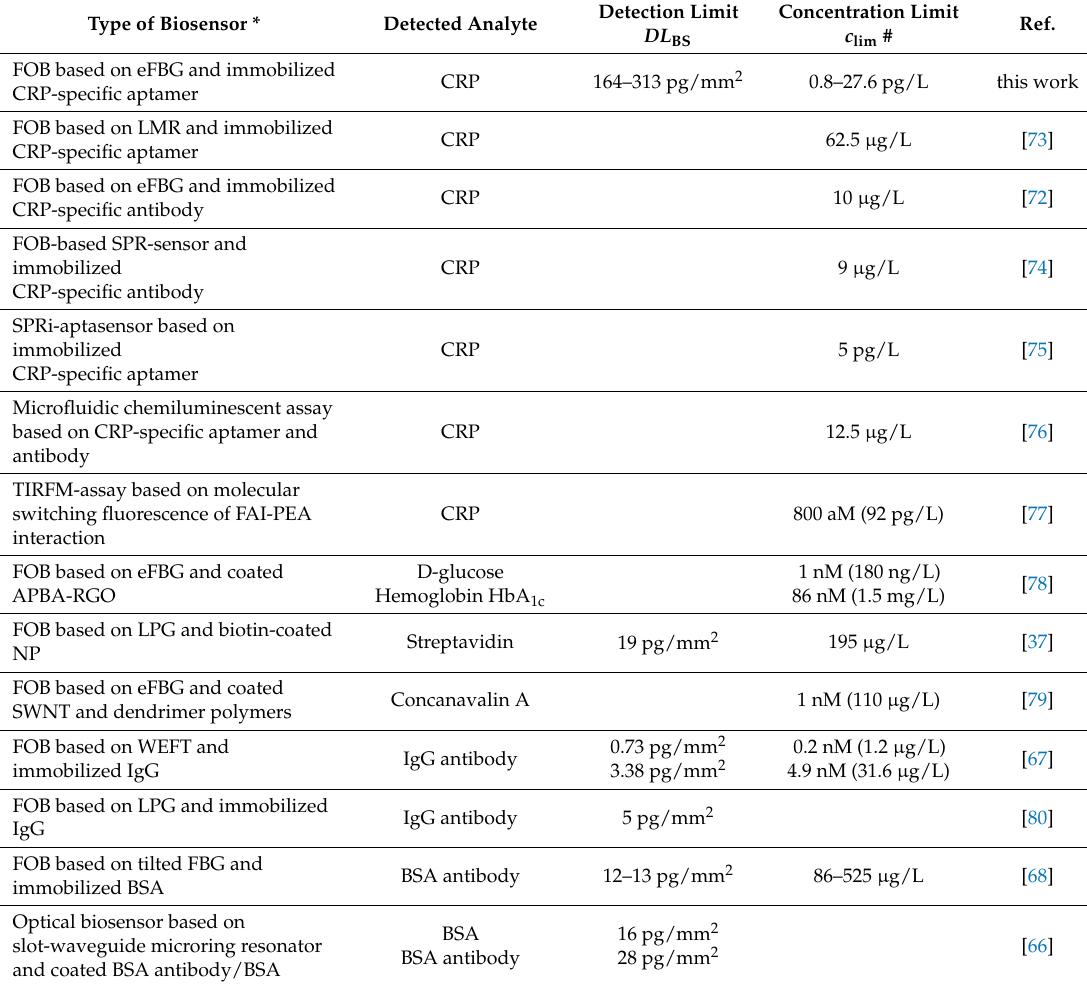
Table 1. List of selected literature-known C-reactive protein (CRP)-specific optical biosensors and other fiber-optical biosensors (FOB), together with their characteristic